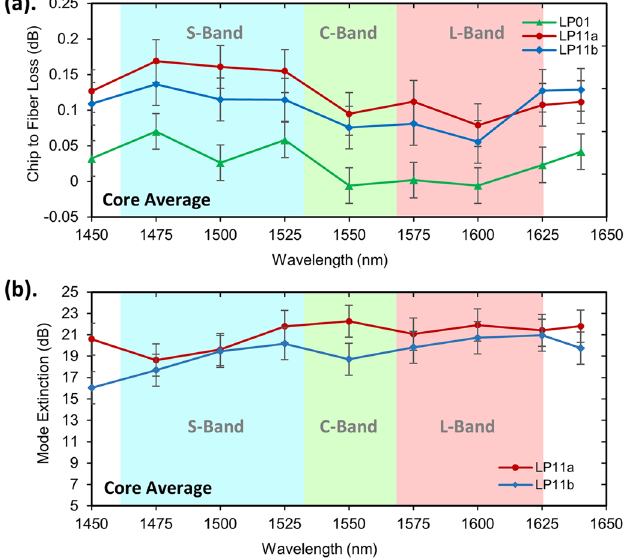
Figure 5. Chip to FM-MCF interface performance. ( a ) The coupling losses between the FM-MCF multiplexer and the 4-core fiber butt-coupled to the end-face of the chip. ( b ) The mode extinction ratios for the FM-MCF multiplexer after a 10 m length of the 4-core fiber butt-coupled to the end-face of the chip. The values are given as averages across all four cores.